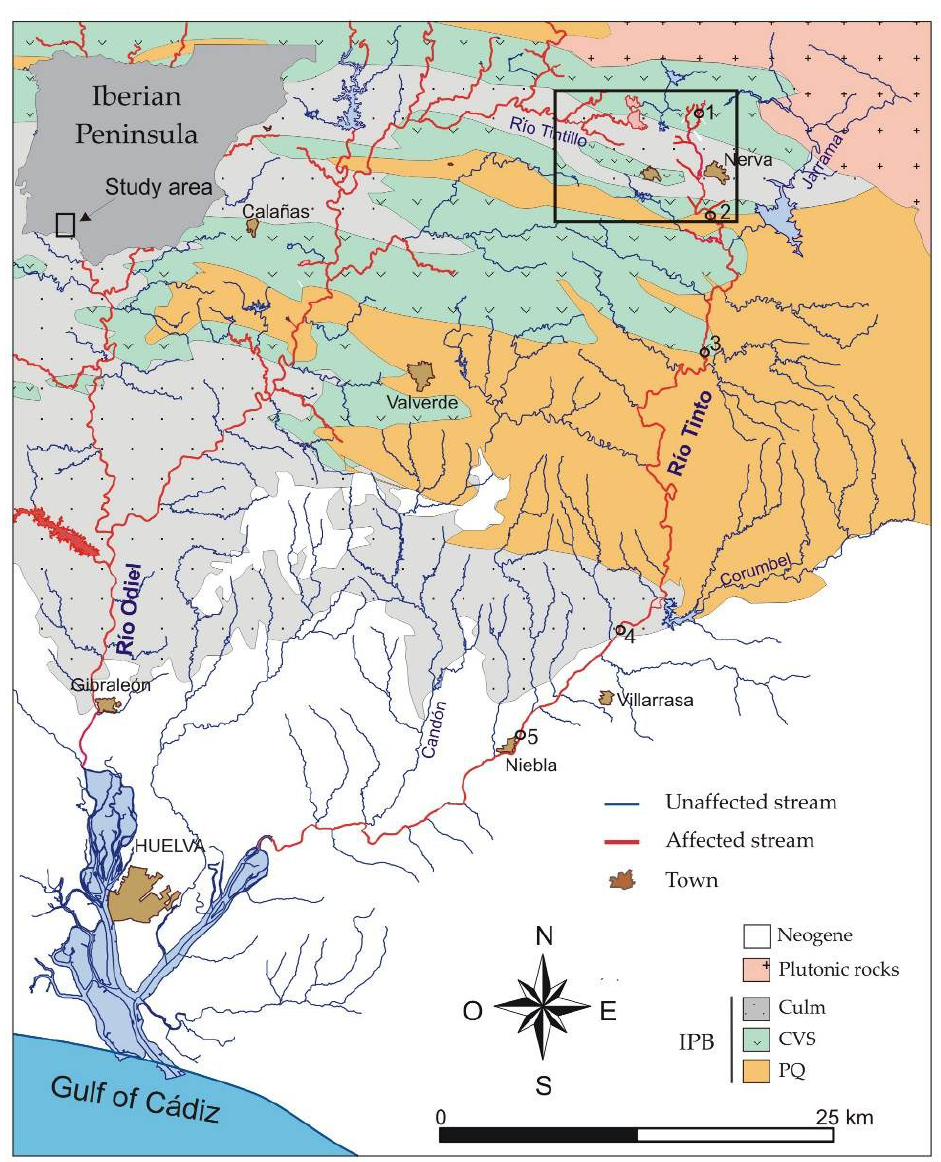
Figure 1. Map of the Río Tinto basin, in red fluvial reaches affected by acid conditions. The main tributaries of Río Tinto are the Jarrama and the Corumbel rivers on its left bank, which have been regulated by reservoirs, and the Candón Creek on its right bank (Figure 1). As the slope decreases, the river broadens losing its fluvial character in the surroundings of Huelva and joining the Odiel River in a common estuary known as Ría of Huelva (Figure